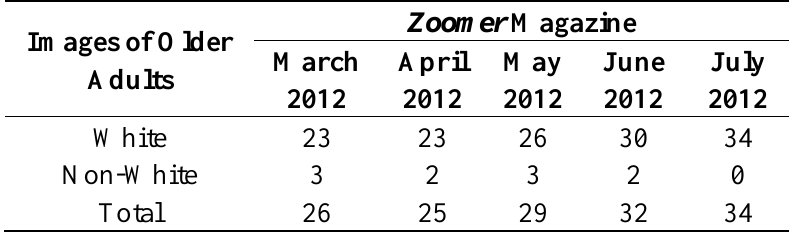
Table 2. Visible Minorities in Zoomer Magazine March–July